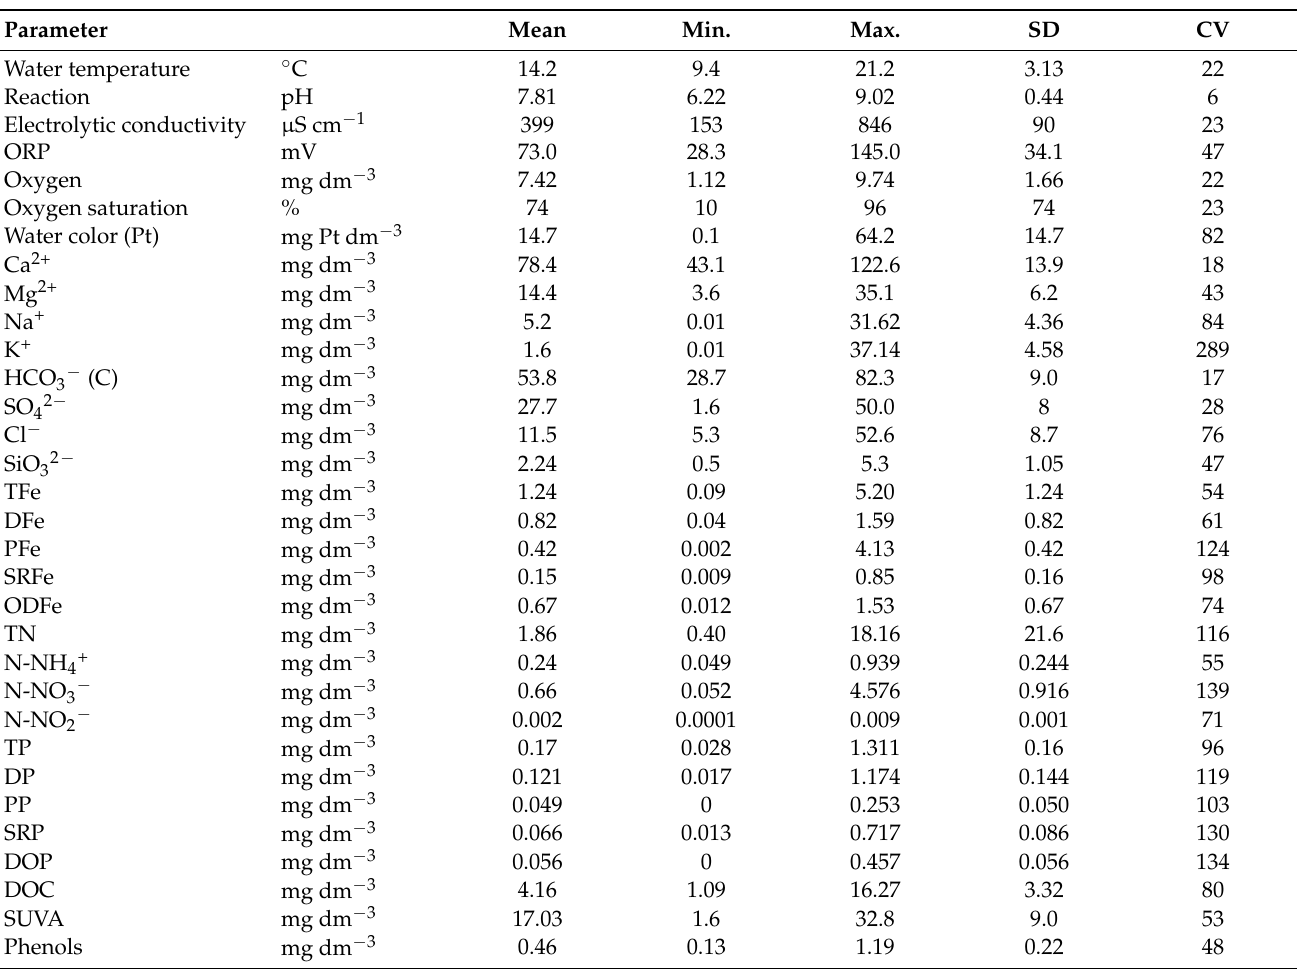
Table 2. Statistical summary of the physical and chemical parameters of the Knyszyn Forest springs